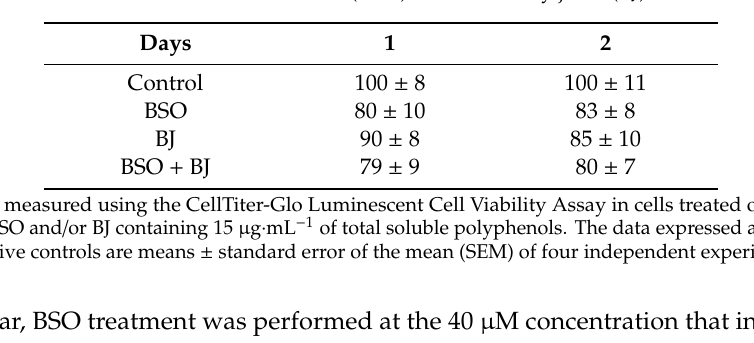
Table 2. E ff ect of butionine sulfoximine (BSO) and blueberry juice (BJ) on cell